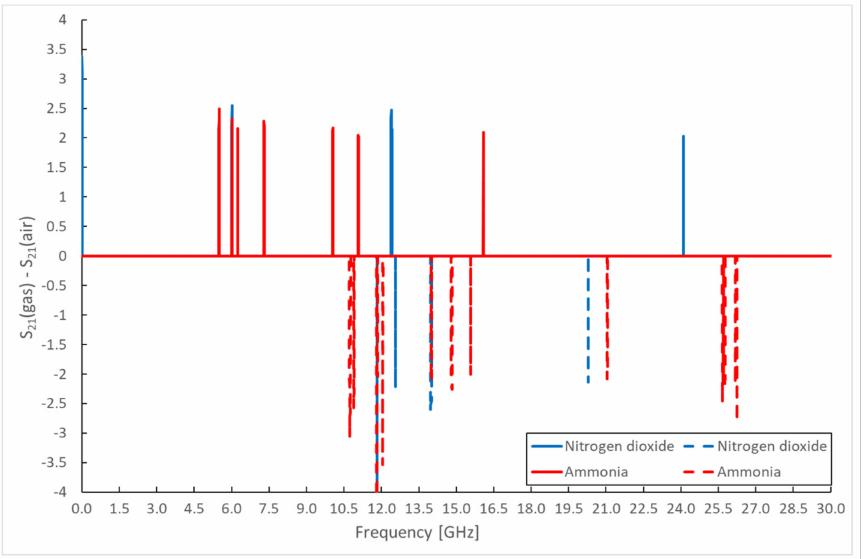
Figure 10. Differential spectrum of sensor response for monitored gases—S 21 parameter